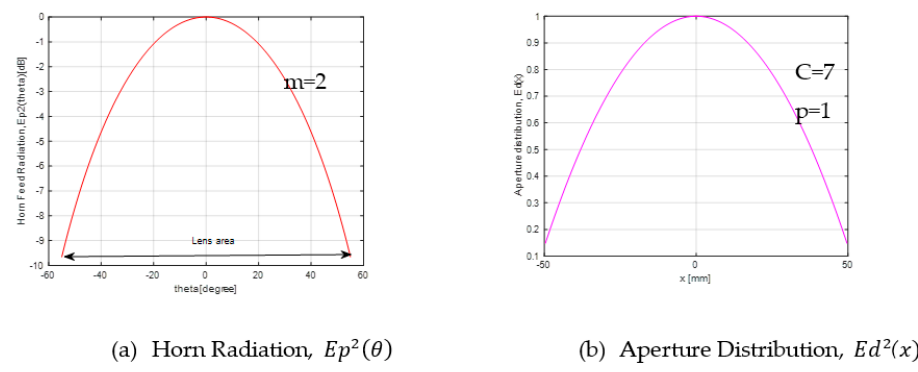
Figure 6. Energy conservation design. Figure 6 . Energy conservation design .